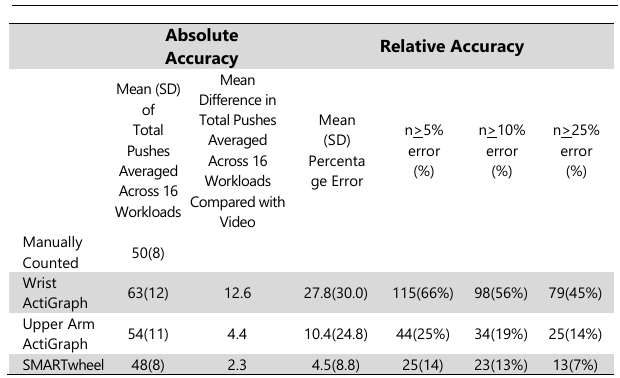
Table 2 . Accuracy of ActiGraph GT3X+ Devices Worn on the Wrist and Upper Arm and SMARTWheel for Capturing Pushes During Manual Wheelchair Propulsion Across 16 Trials of Increasing Workloads in a Sample of 11 Non-disabled Young Persons.